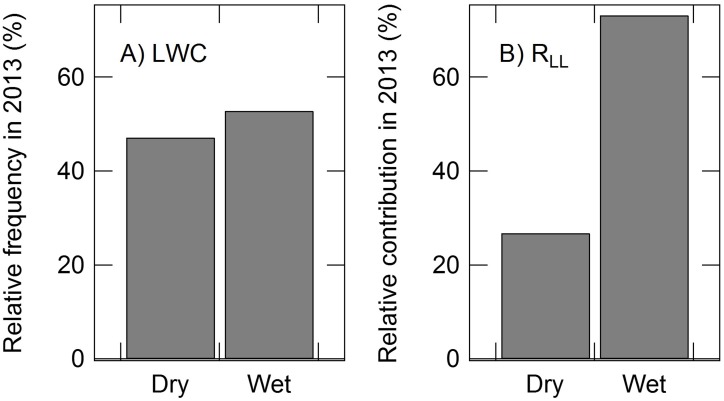
Histograms of the relative frequency of “Dry” and “Wet” periods in relation to water content of the leaf litter layer (LWC), and the relative contribution of estimated leaf litter respiration (R
LL) in 2013.The daily mean LWC (A) and R
LL (B) were used to present histograms. Estimated respiration rates were calculated using a function based on temperature (T) and water content (WC). R
LL = 0.29e0.059T[WC/(95.04+WC)]. The daily mean LWC and R
LL were defined as Dry or Wet based on LWC. Days in which daily mean LWC <0.75 g g−1 were defined as Dry periods, while days in which daily mean LWC ≥0.75 g g−1 were defined as Wet periods.